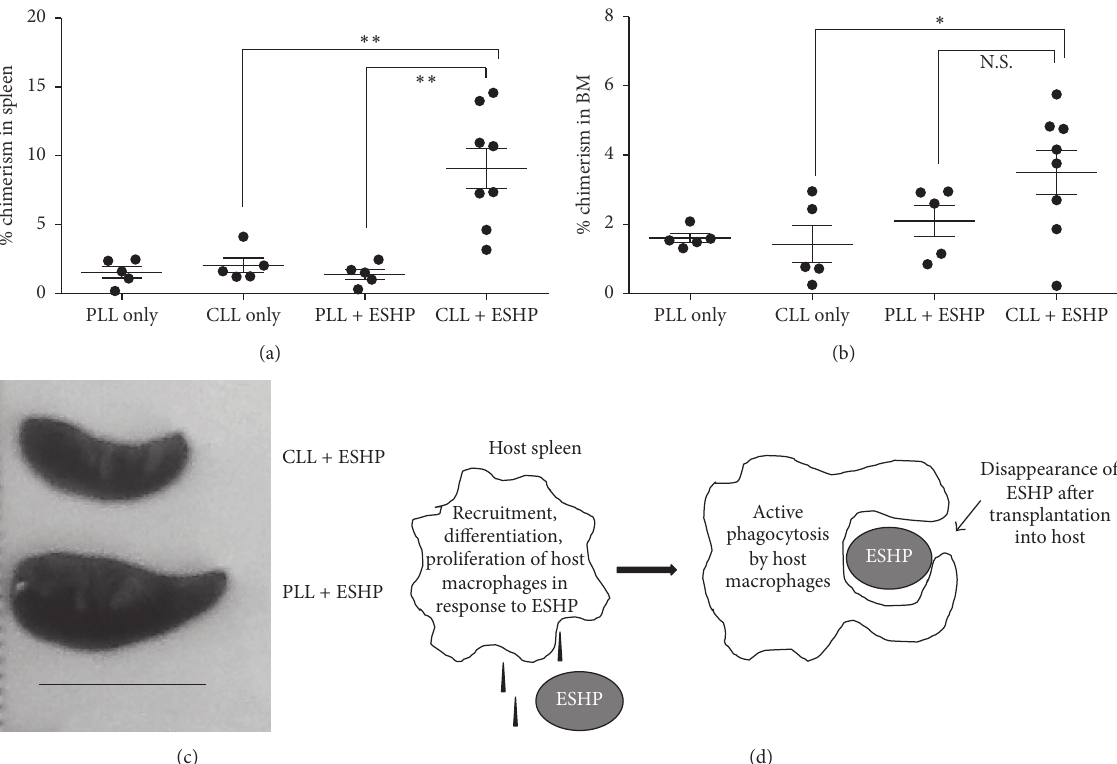
Figure 5: Clodronate depletion of host macrophages increases hematopoietic chimerism in ESHP recipients. (a) Photo of one representative ESHP recipient spleen treated with clodronate-loaded liposomes (CLL) or phosphate-buffered saline-loaded liposomes (PLL); scale bar = 1cm. (b) Percent donor chimerism in the BM of mice receiving CLL or PLL with or without CD41 + ESHP transplant. (c) Percent donor chimerism in the spleens of mice receiving CLL or PLL with or without CD41 + ESHP transplant. PLL alone ( 𝑛 = 5 ), CLL alone ( 𝑛 = 5 ), PLL with ESHP ( 𝑛 = 5 ), and CLL with ESHP ( 𝑛 = 8 ). Bars represent mean ± SEM. (d) Model of macrophage ESHP interactions in the spleen. ∗ 𝑝 < 0.05 ; ∗∗ 𝑝 <